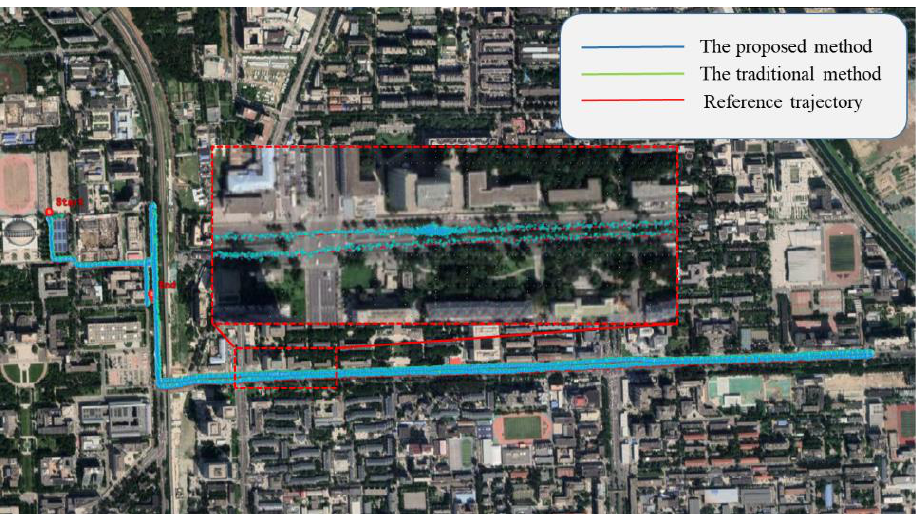
Table 3. Mean and RMSE of position error under vehicle stationary